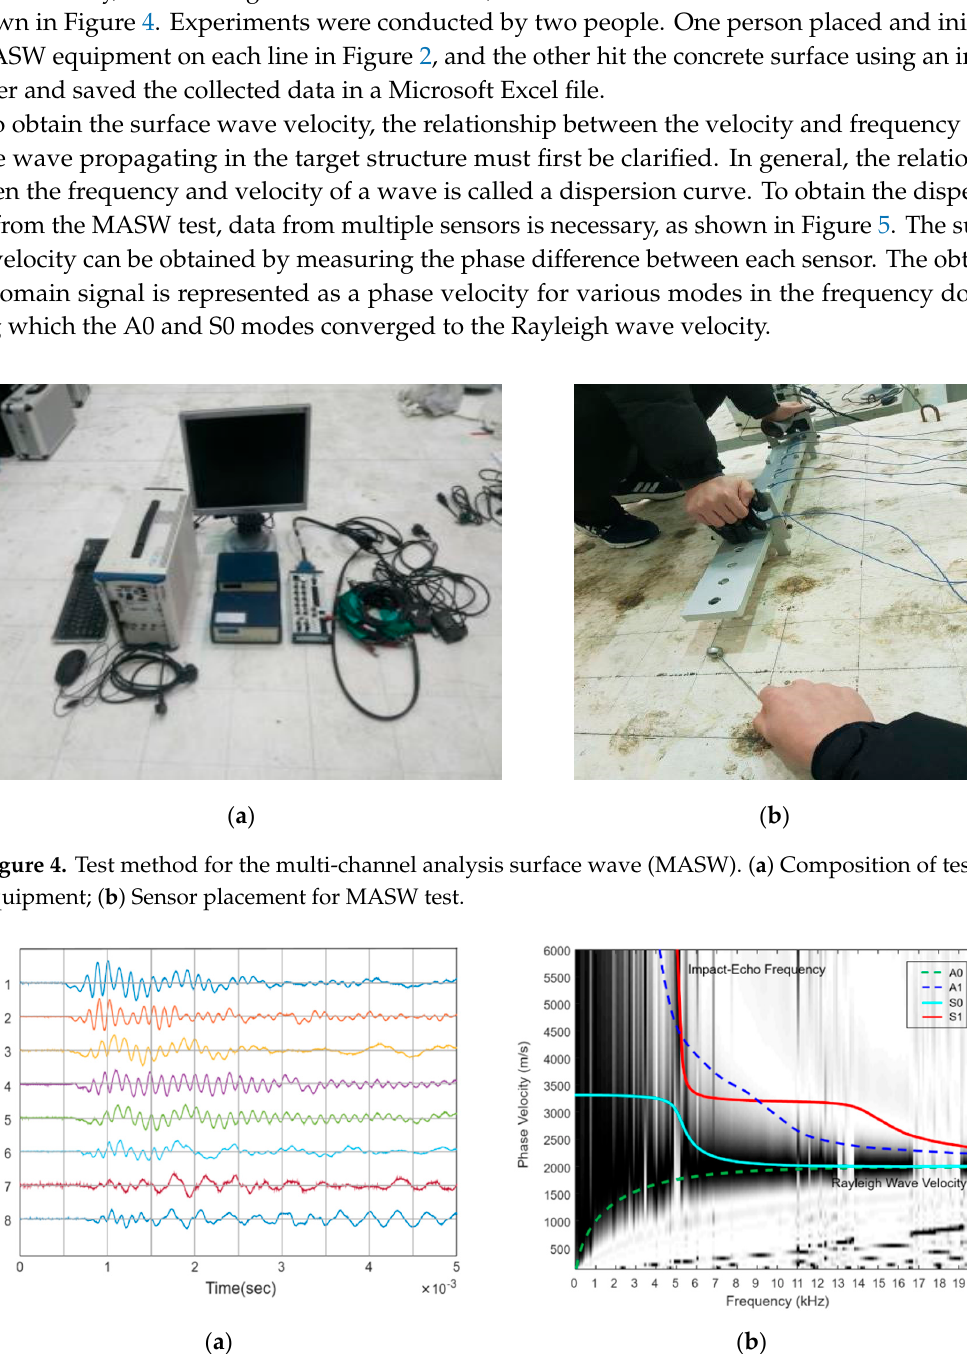
Figure 5. Use of the dispersion curve to determine the R-wave velocity. ( a ) Time domain; ( b ) Dispersion curve.